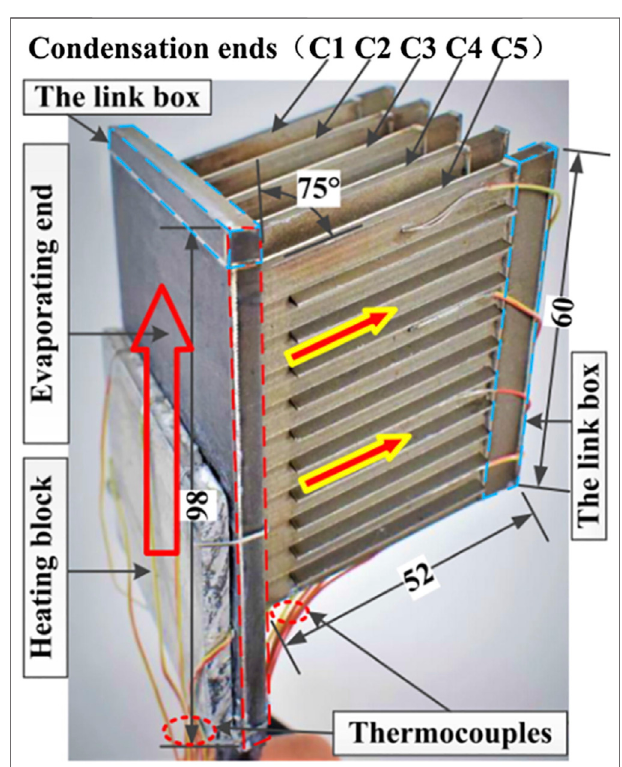
FIGURE 8 | Schematic diagram of the novel vertical pulsating heat pipe radiator (Xiahou et al., 2019).